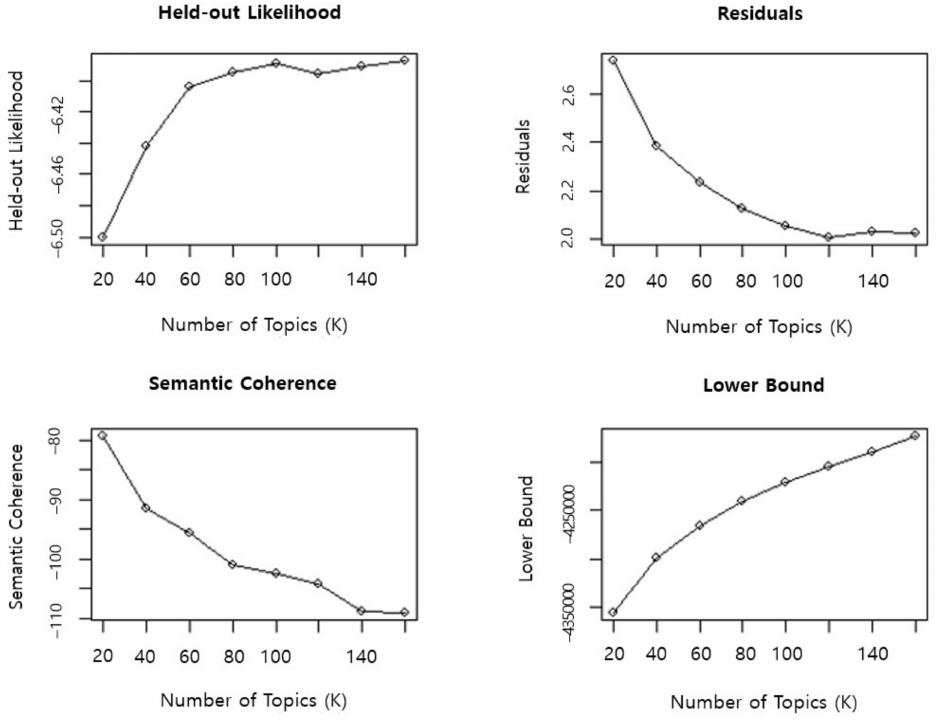
Figure 2. Diagnostic values by the number of